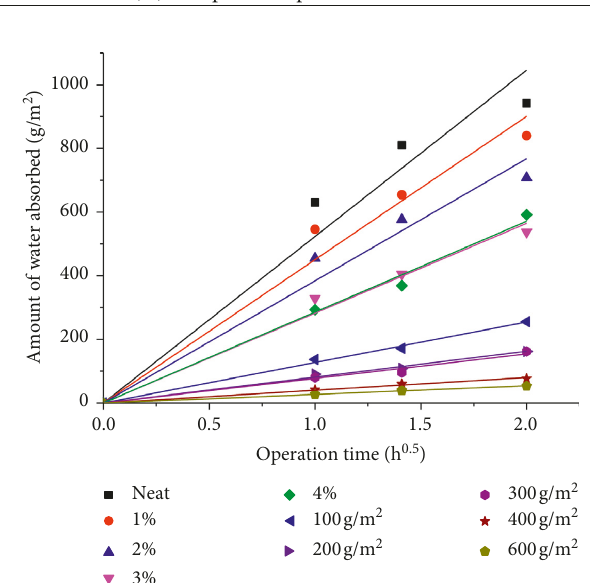
Figure 6: Capillary water absorption of concrete with various